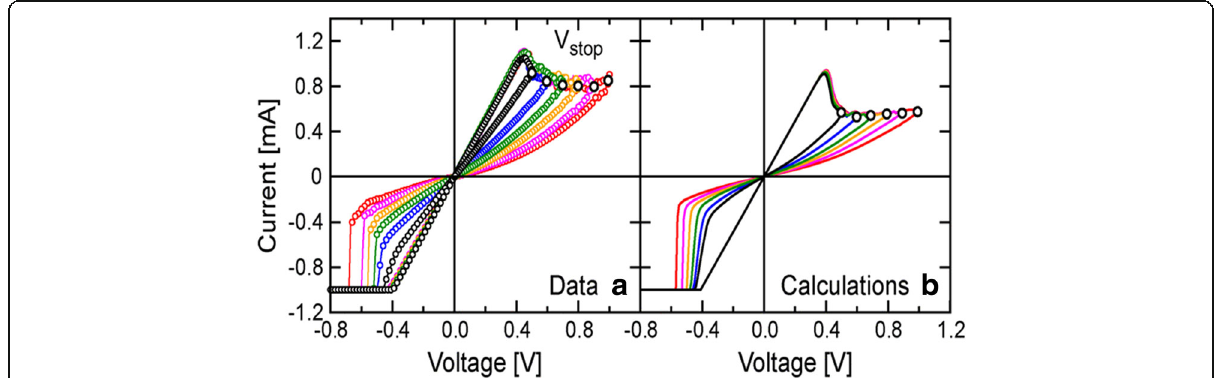
Fig. 19 a Measured and b calculated I - V curves, for reset ( V > 0) and set ( V < 0) transitions, obtained by applying triangular voltage sweeps. For preparing a reset state with variable R , the reset sweep applied to an initial set state with R = 400 Ω , is interrupted at V stop . Then, the set sweep is applied, showing that V set increases with V stop , hence with R